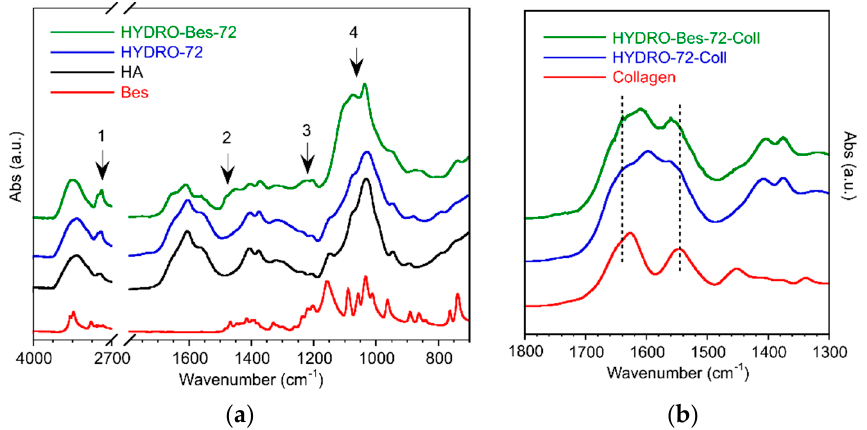
Figure 2. ATR-FTIR spectra of crosslinked gels: ( a ) HYDRO-72 and HYDRO-Bes-72 in the region between 4000 and 700 cm − 1 . The spectra are compared to those of pristine hyaluronic acid and Bes. ( b ) HYDRO-72-Coll, HYDRO-Bes-72-Coll, and collagen spectra in the 1800–1300 cm − 1 region.